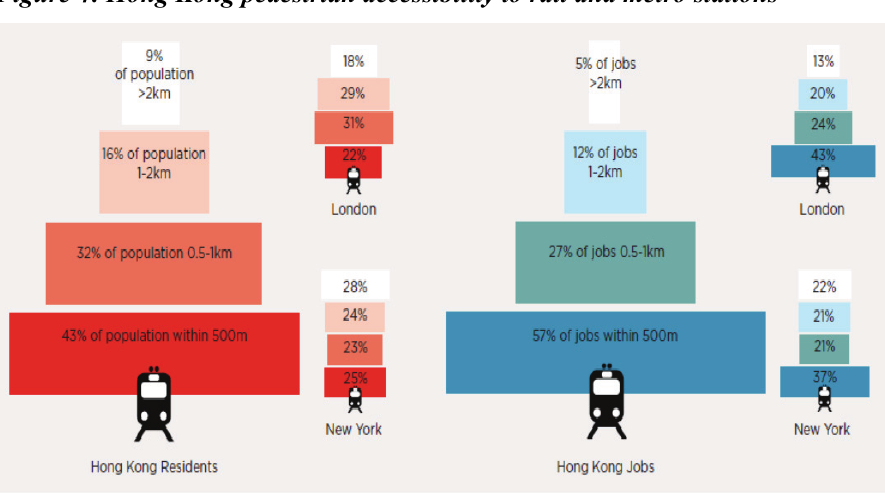
Figure 4: Hong Kong pedestrian accessibility to rail and metro